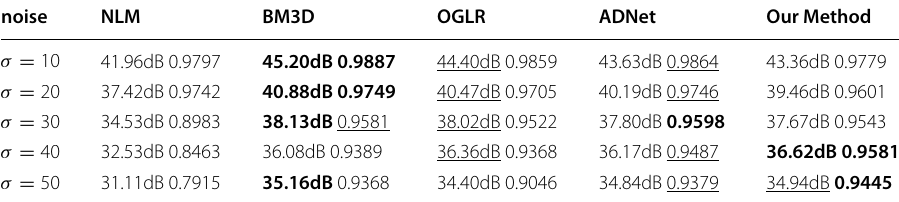
Bold and underline to mark the best and the second best results for each quality index, respectively